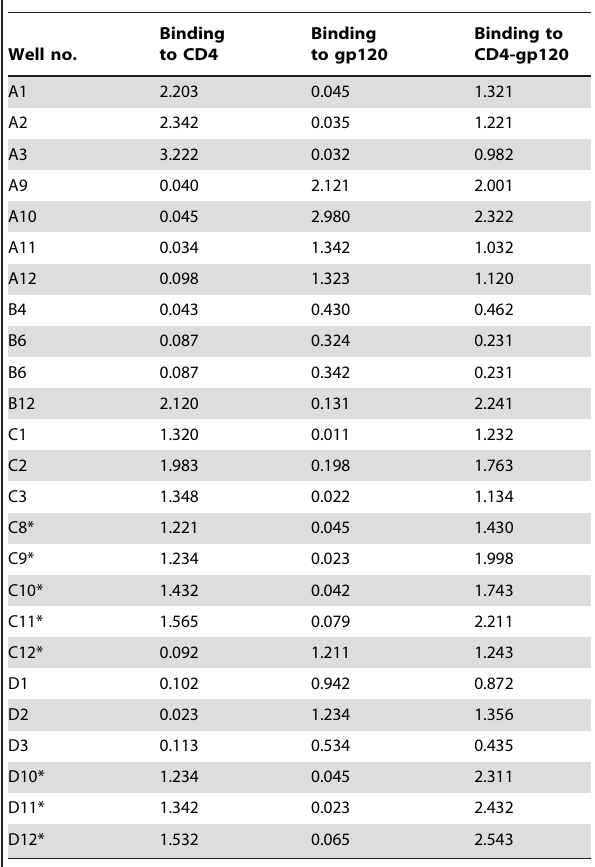
Binding activity to the indicated solid-phase antigens of IgG present in culture supernatants from hybridomas derived from spleen cells of mice immunized with NIH-3T3 cells infected with vaccinia recombinant vCB43, expressing Env from the R5 HIV-1 isolate Ba-L, and complexed with 2-domain sCD4. Binding activity was measured with culture supernatants diluted 1:1 (see methods). Values are qualitative, since different microcultures contained different numbers of cells. Asterisks indicate supernatants where an increased binding to the 2D-CD4/gp120 (Ba-L) complex was observed as compared to the binding to each moiety separately.